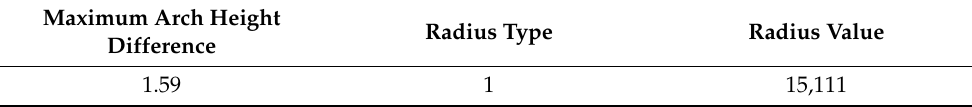
Table 10. Optimization results of the secondary keel.